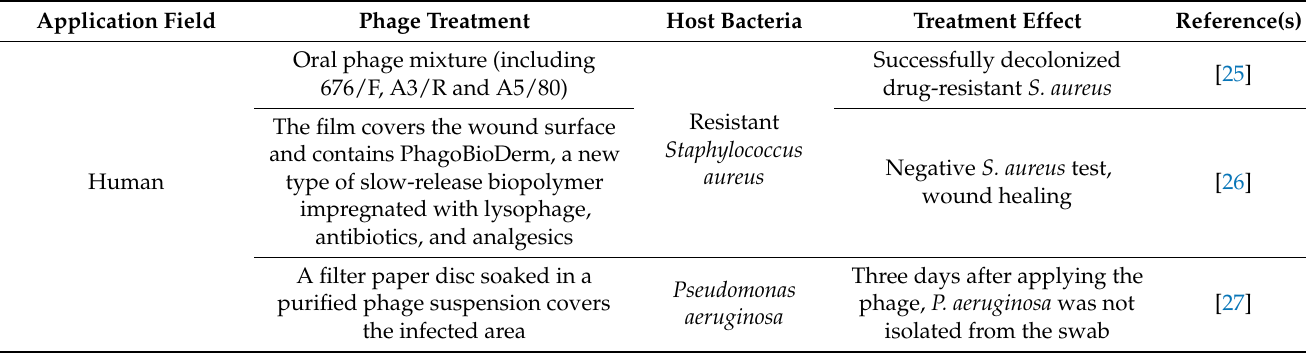
Table 1. Application field of phage therapy and corresponding host